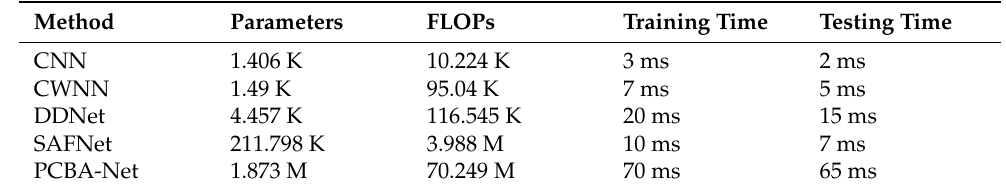
Table 8. The parameters, FLOPs, training time, and testing time of the proposed PCBA-Net and four CNN-based